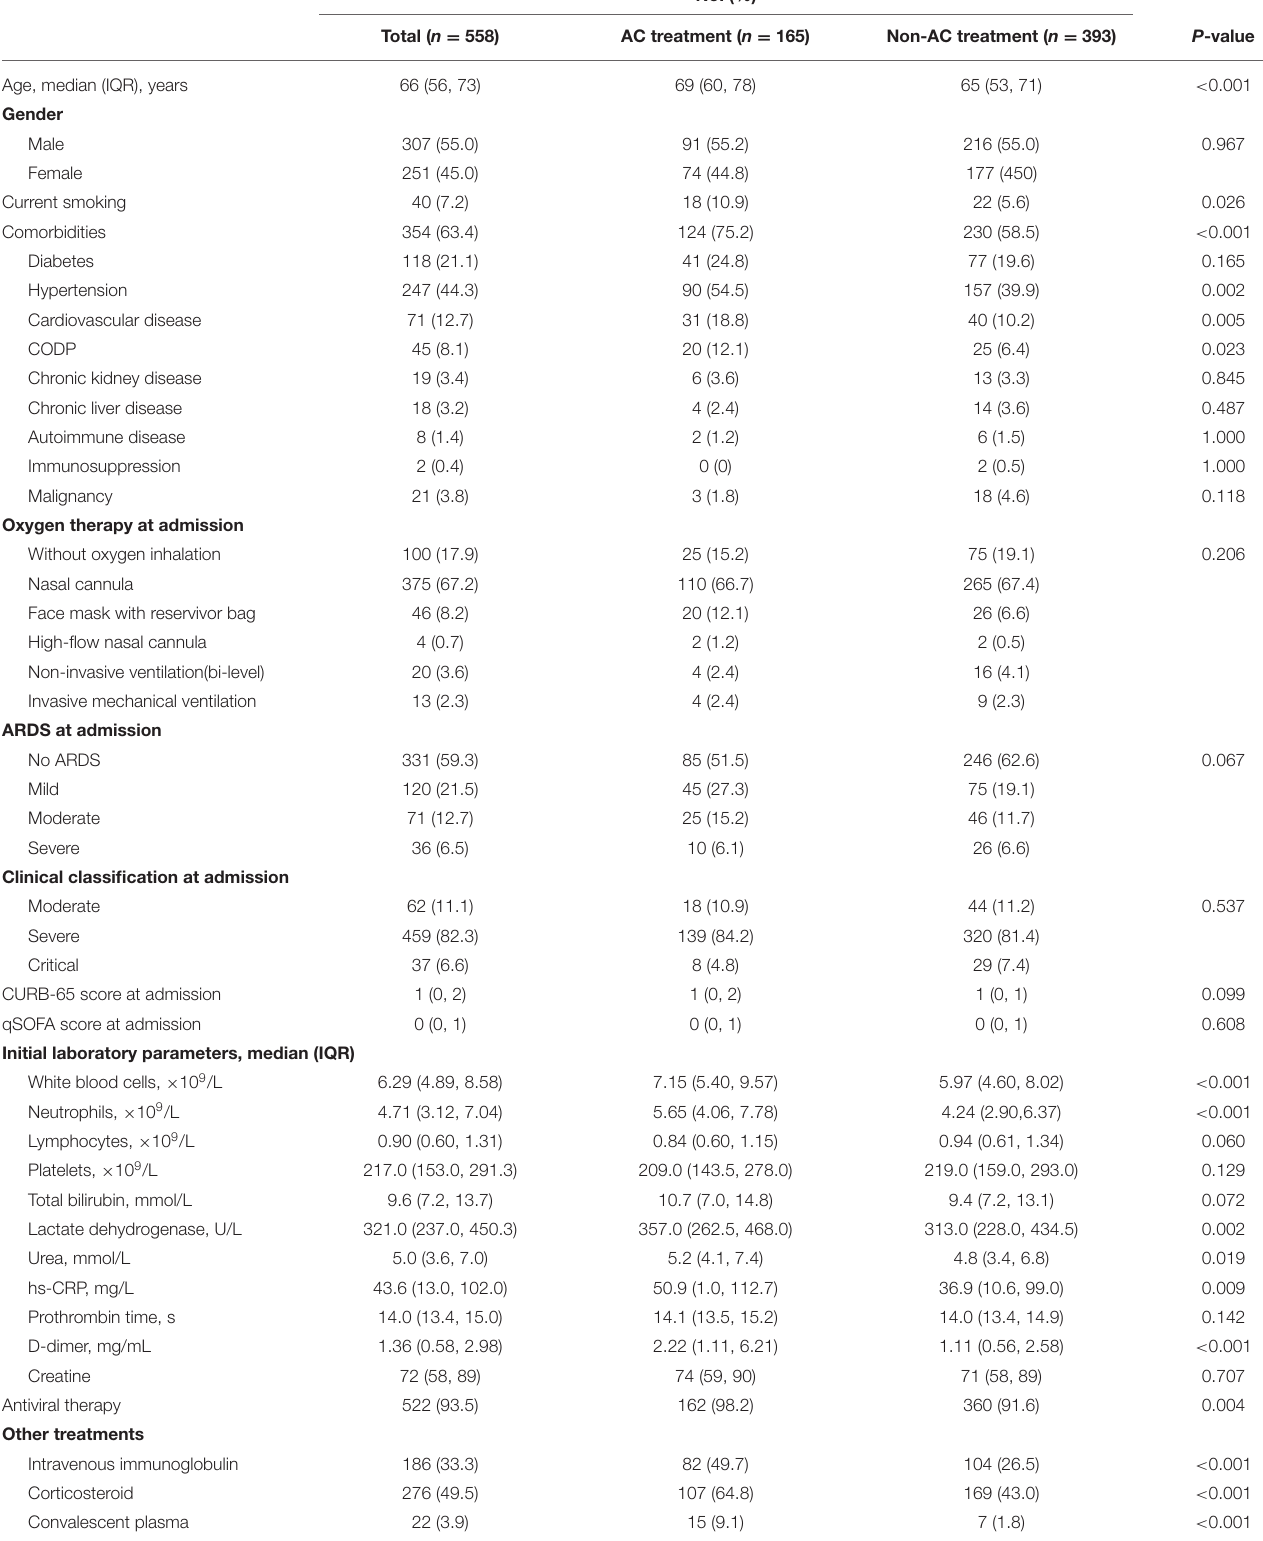
TABLE 1 | Patients Baseline Characteristics and Treatments in propensity score matched